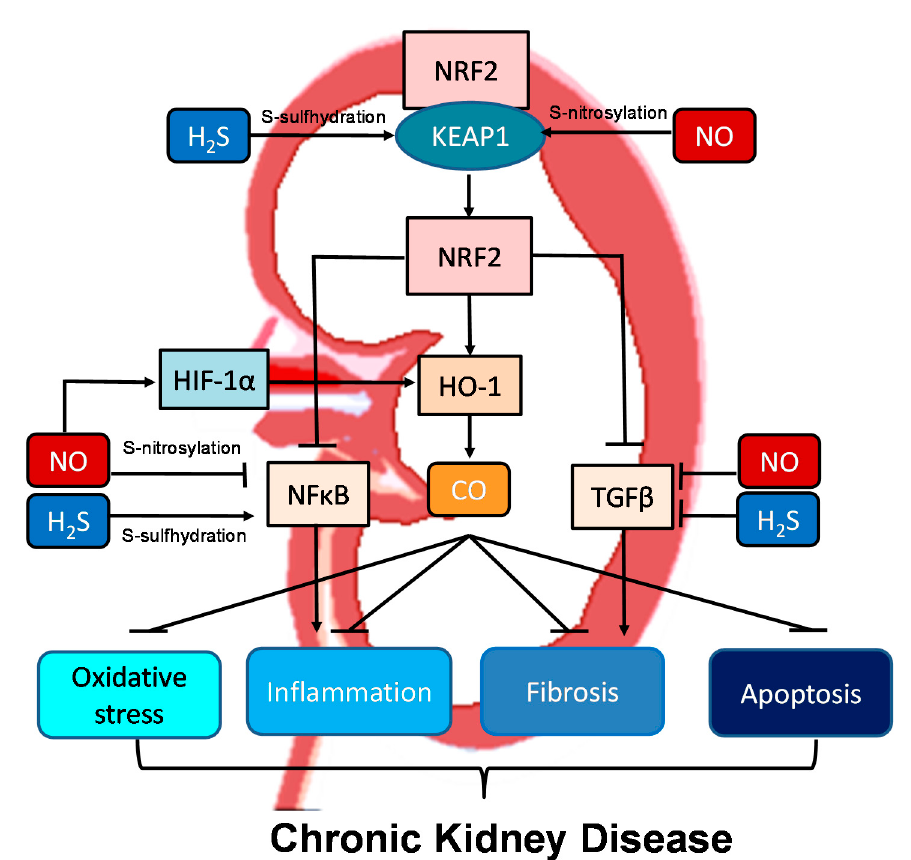
Figure 2. Schematic illustration of the crosstalk among NO, CO, and H 2 S and downstream nuclear factor erythroid 2-related factor 2 (NRF2)–heme oxygenase-1 (HO-1) signaling able to protect chronic kidney disease progression. Activation of the NRF2–HO-1–CO signaling pathway suppresses nuclear factor κ B (NF κ B) and transforming growth factor- β (TGF- β ), consequently inhibiting oxidative stress, inflammation, fibrosis, and apoptosis. NO and H 2 S can activate NRF2 via S- nitrosylation and S-sulfhydration of Kelch-like ECH associated protein 1 (KEAP1), respectively. Via S-nitrosylation, NO can also inhibit NF κ B-induced inflammation and activate hypoxia-inducible factor-1 α (HIF-1 α ), a HO-1 inducer. Additionally, NF κ B can also be regulated by H 2 S via S-sulfhydration. NO and H 2 S also reduce TGF β -mediated fibrosis.